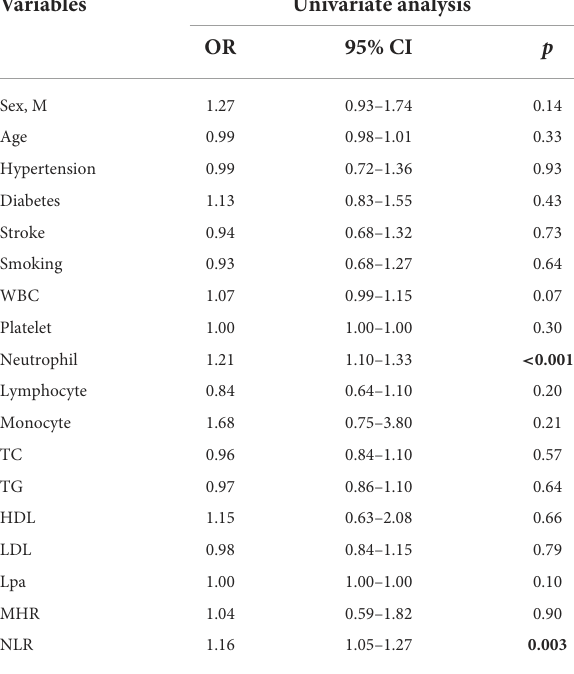
TABLE 6 Univariate ordinal logistic regression of factors for the mild stenosis group, moderate stenosis group, and severe stenosis group. Variables